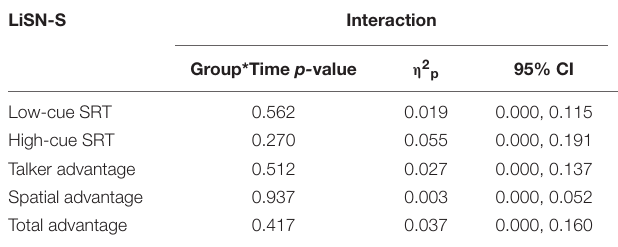
TABLE 6 | The p -values, η 2 p and CIs of the effect size, of the five LiSN-S scores.